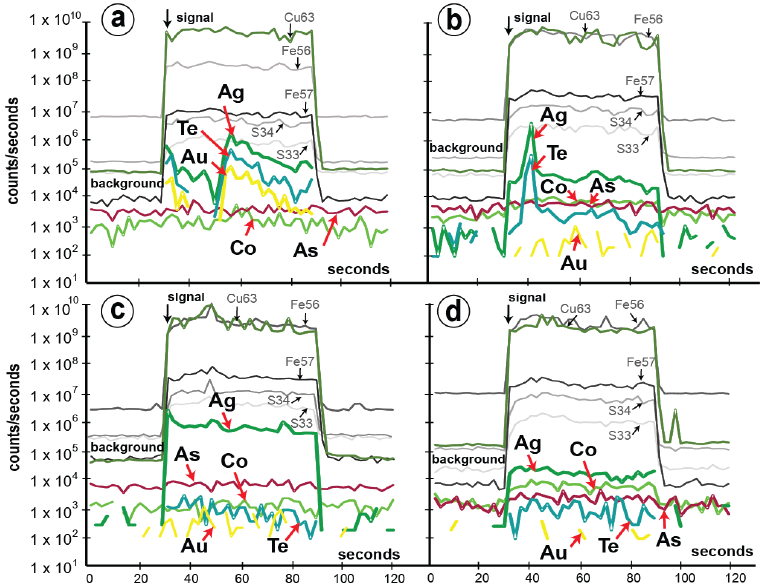
Figure 4. LA-ICP-MS patterns (in counts per second) for selected trace-element signals depicting a typical pattern for ( a ) invisible particles of Ag-Au-Te in bornite; ( b ) invisible particles of Ag-Te in chalcopyrite; ( c , d ) invisible silver in the mineral’s lattice of bornite and chalcopyrite,